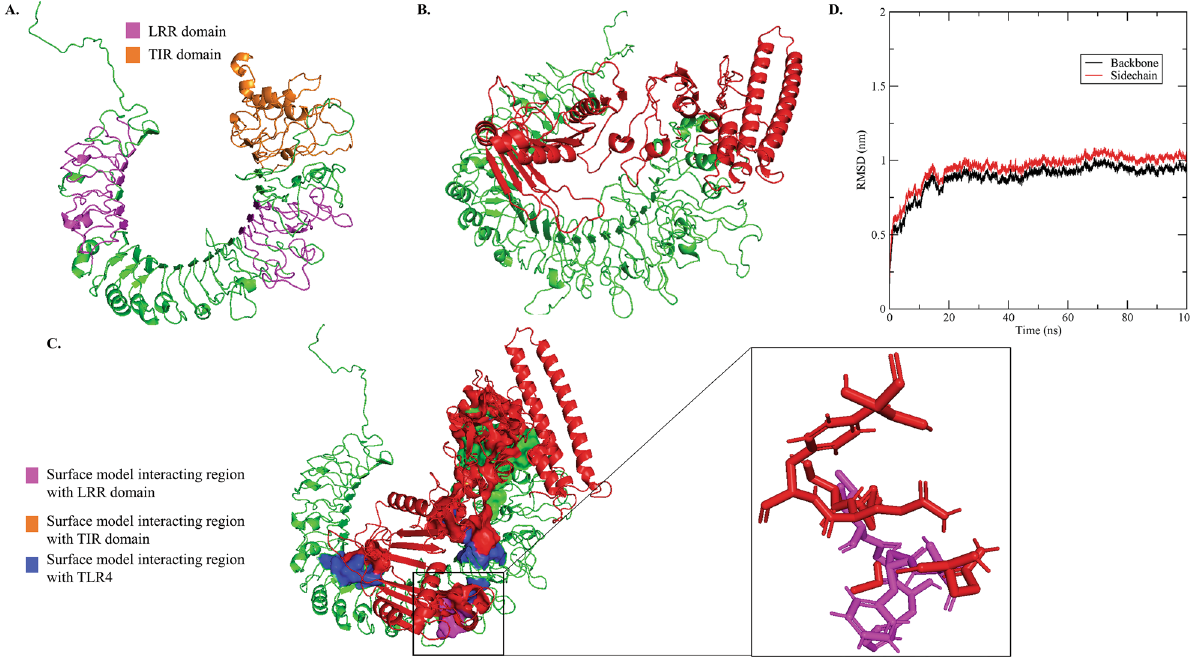
Figure 3. Docking studies of multi-epitope protein-based subunit vaccine candidate against LSDV and modeled bovine TLR4. ( A ) Three-dimensional model of bovine TLR4 obtained by homology modeling and refinement. LRR domain and TIR domain shown in magenta and orange color, respectively, ( B ) Docked complex of TLR4 and multi-epitope protein based subunit vaccine candidate, where green color represents the TLR4, red color represents the multi-epitope vaccine candidate, blue color and green color with surface models showed the interacting region of the multi-epitope protein and bovine TLR4, magenta with surface model showed the interacting region of LRR domain of TLR4 with multi-epitope protein, ( C ) Binding residue of the LRR domain of the TLR4 and multi-epitope protein with sticks model, ( D ) Molecular Dynamics Simulation of multi-epitope protein and bovine TLR4 for 100